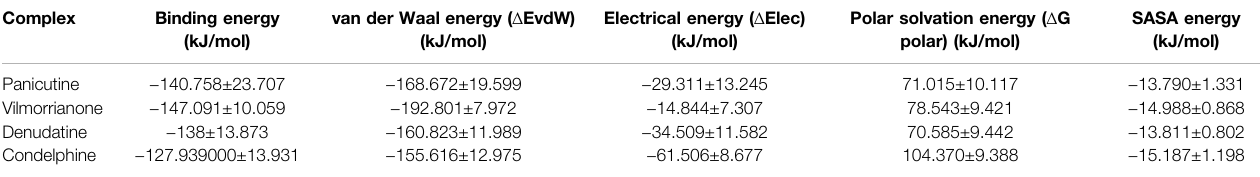
TABLE 4 | Calculated free binding energy of docking complexes of M pro and natural alkaloids (panicutine, vilmorrianone, denudatine, and condelphine). Complex Binding energy van der Waal energy ( Δ EvdW) Electrical energy ( Δ Elec) (kJ/mol) (kJ/mol)